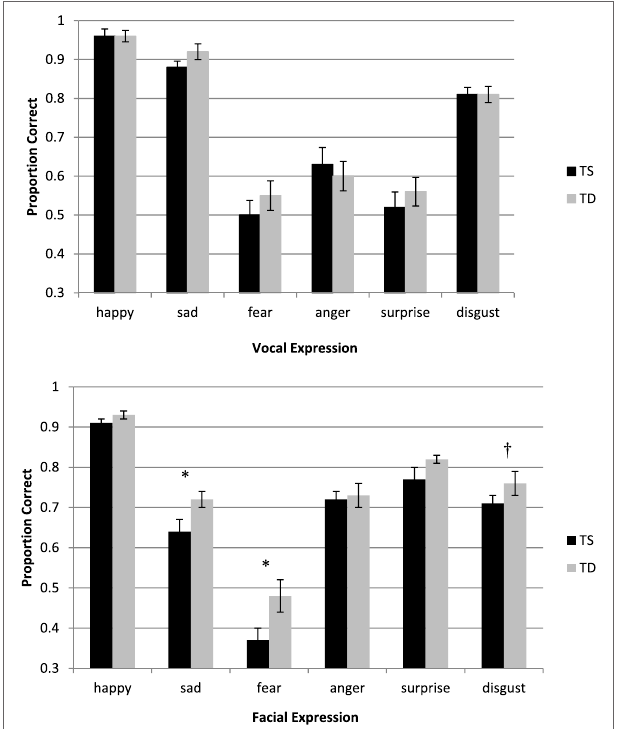
FigUre 1 | Top—accuracy in the auditory expression identification task as a function of group (TS and TD). Bottom—accuracy in the facial expression identification task as a function of group (TS and TD). The bottom graph is reprinted from Anaki et al. (20). Face perception in women with TS and its underlying factors, Neuropsychologia , 90 , 274–285, with permission from Elsevier. Note—* p ≤ 0.05, † significant only in a three-way interaction which included Group, Expression Type, and Morphing Level. TS, Turner syndrome; TD, typically